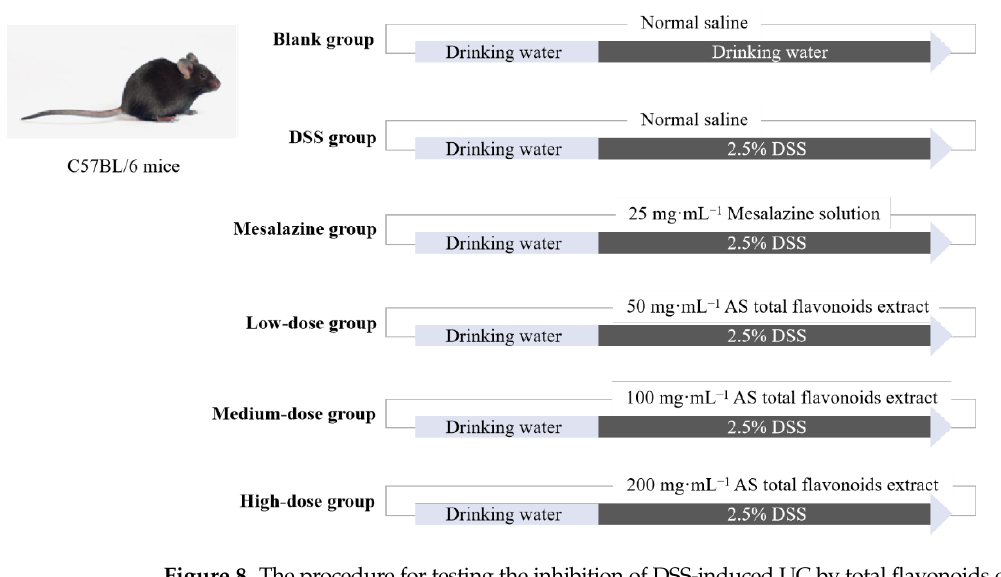
Figure 8. The procedure for testing the inhibition of DSS-induced UC by total flavonoids of Acanthopanax .